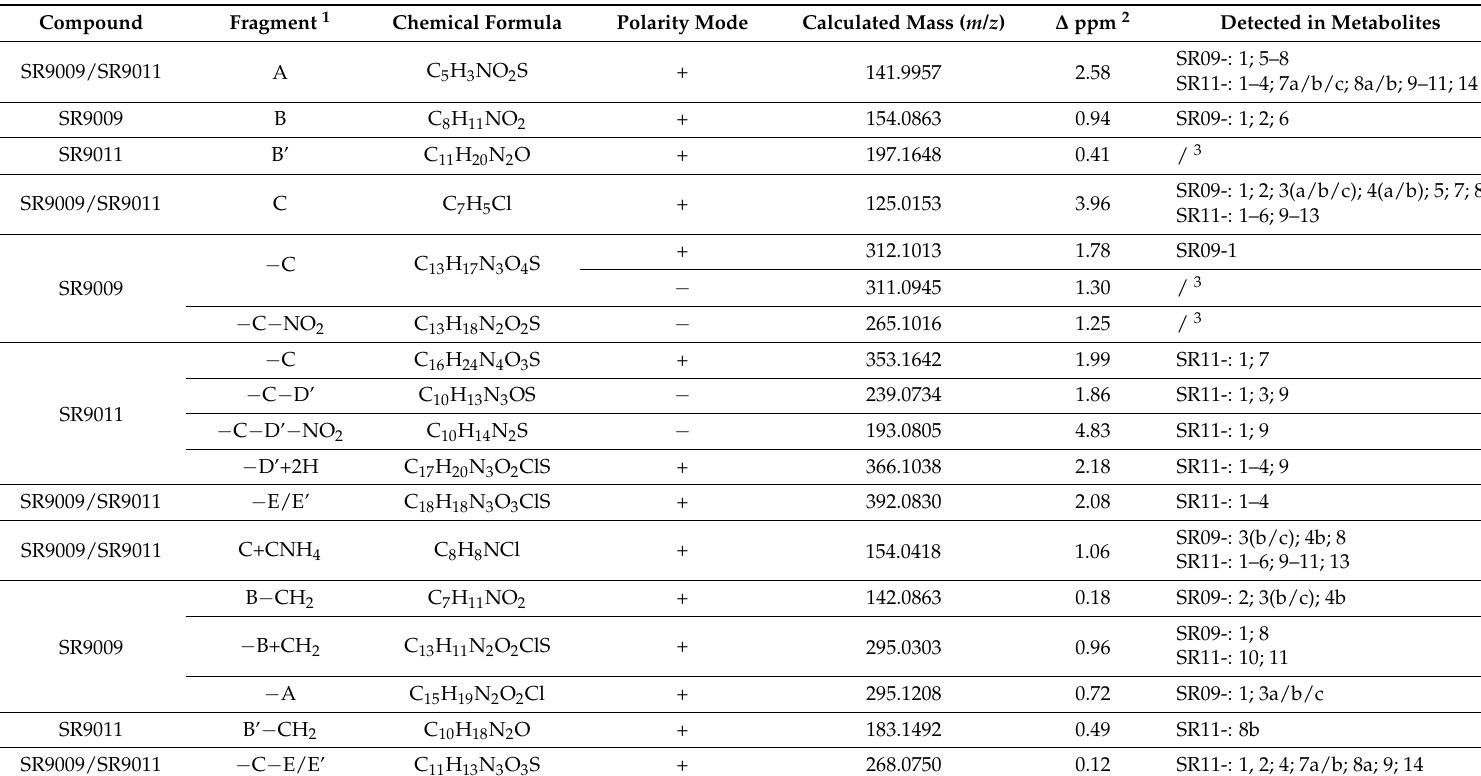
Table 1. Liquid chromatography–high resolution mass spectrometry (LC–HRMS) product ion scans of SR9009 and SR9011. Common product ions of the parent compounds and metabolites are also